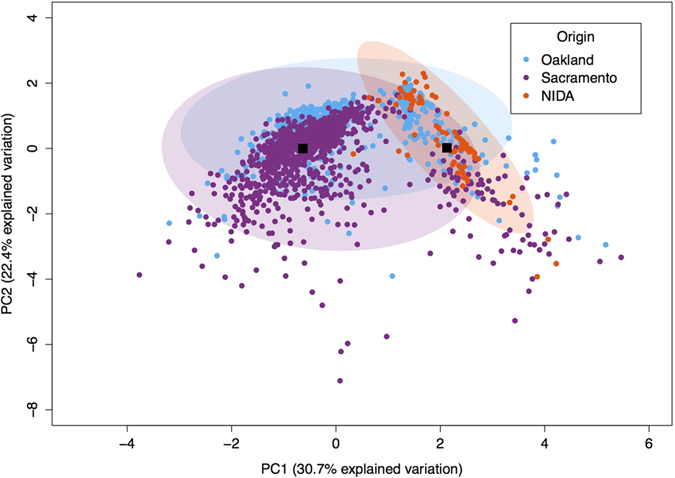
PC1 vs PC2 for three locations.Most of the points from the two main PC axes overlap demonstrating similarities between the three locations in their content. The black boxes represent the means of the two clusters after the k-means analysis.